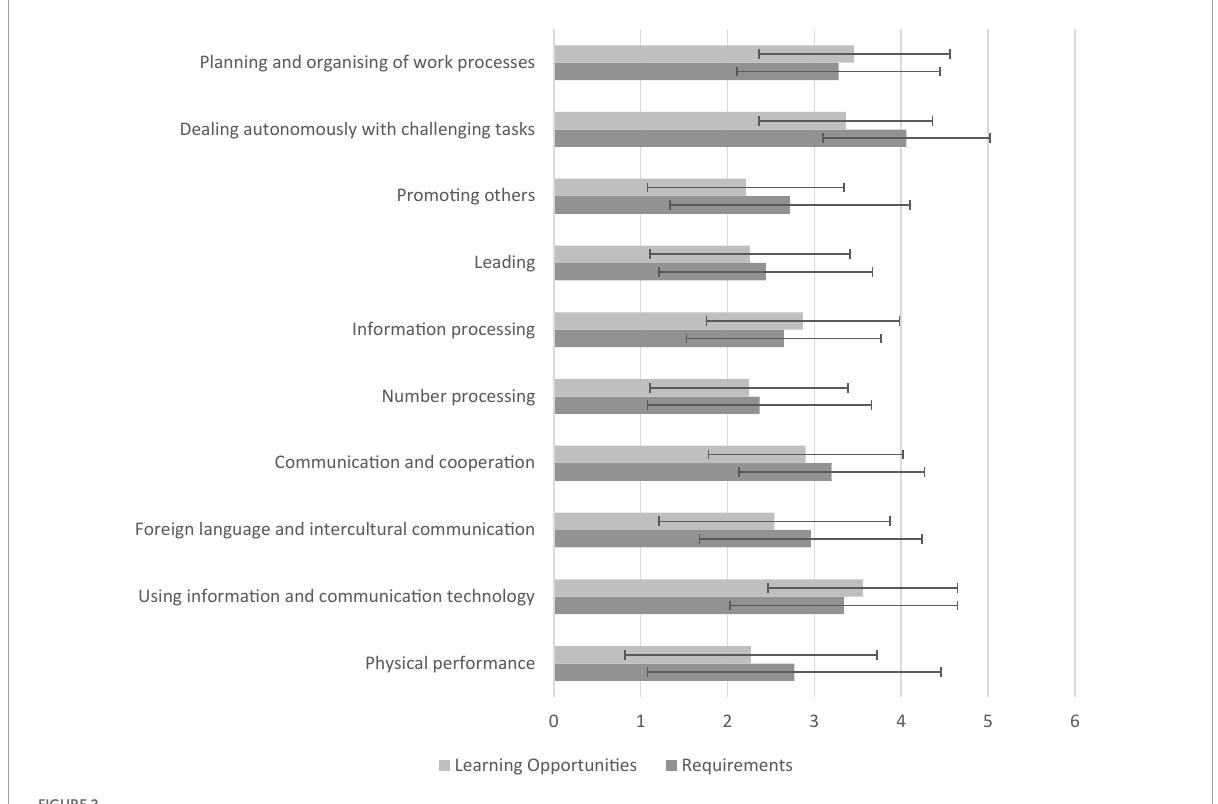
FIGURE2 Perception of requirements in the view of graduates and learning opportunities in the view of